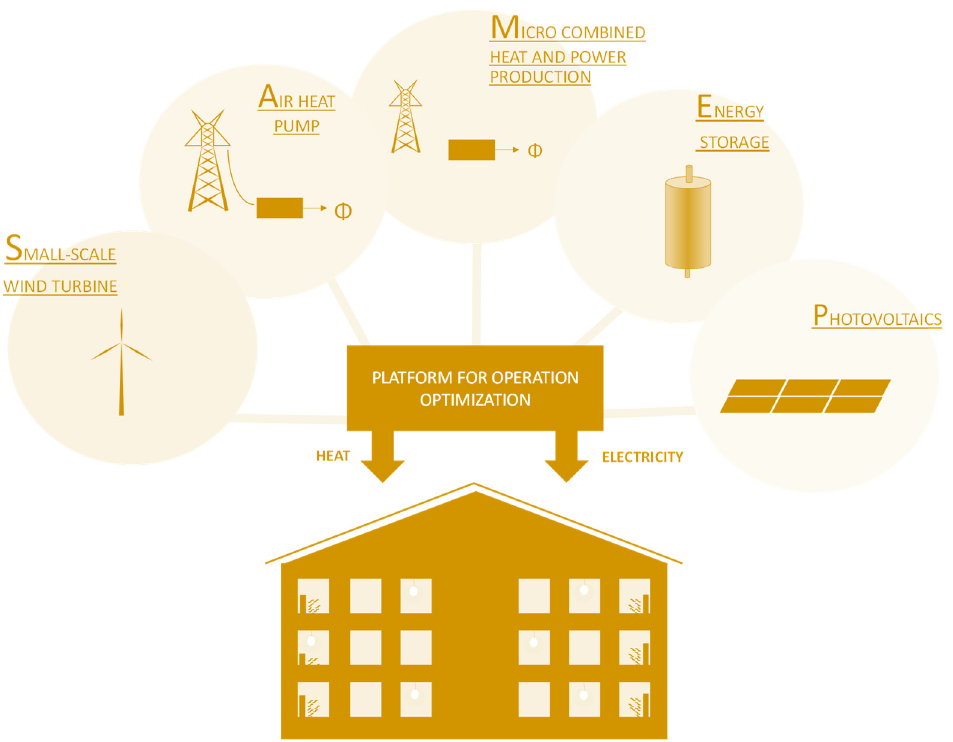
Figure 4. Technologies adopted in the work for the renewable production, conversion, and storage of energy.